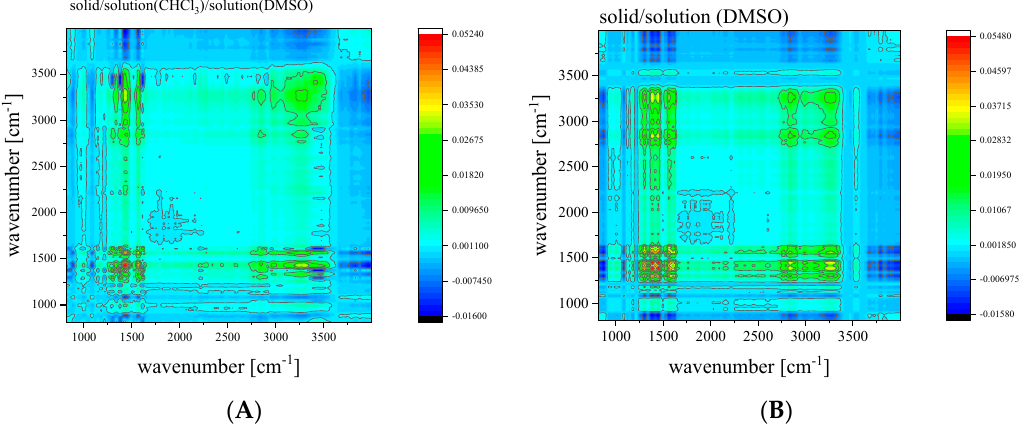
Figure 5. Synchronous 2-D correlation spectra constructed from the vibrational spectra of the solid and CHCl 3 ( A ) or DMSO ( B ) solution presented in Figure 3.